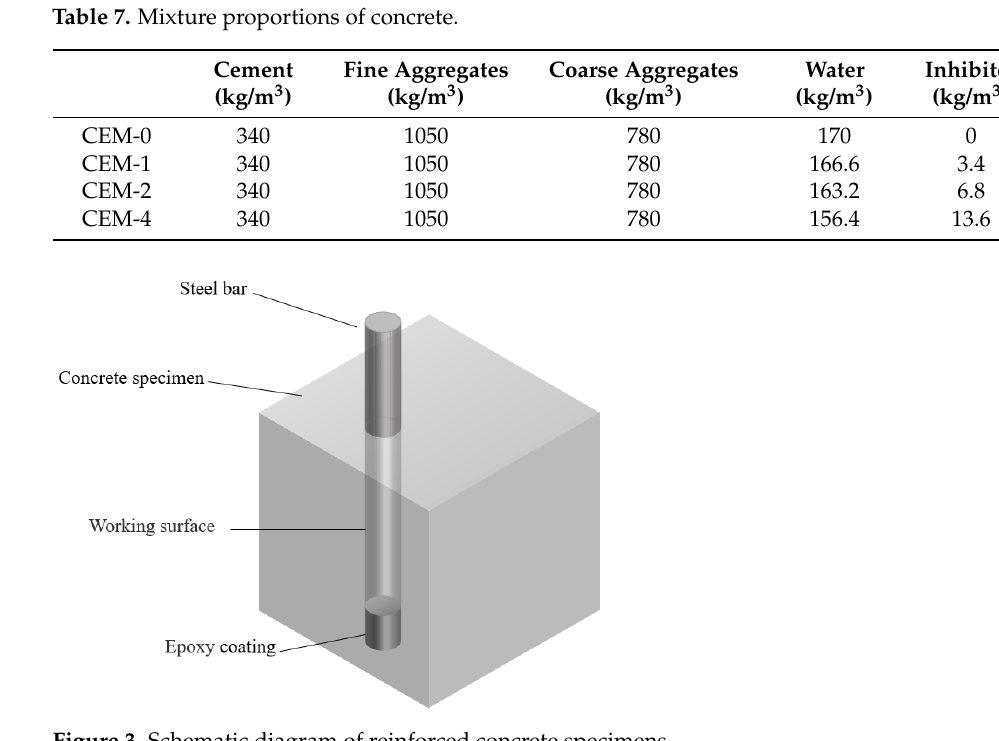
Figure 3. Schematic diagram of reinforced concrete specimens. Table 7. Mixture proportions of concrete.